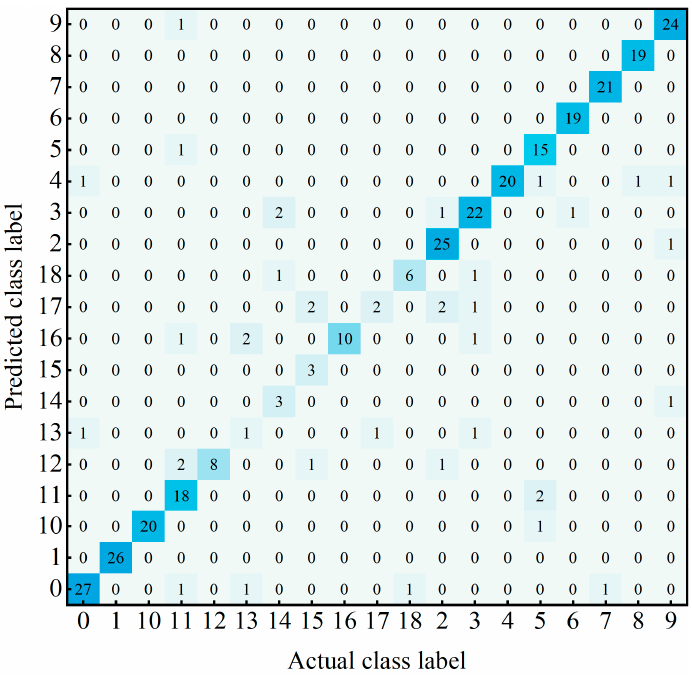
Figure 14. Confusion matrix of ReVI on the test dataset.